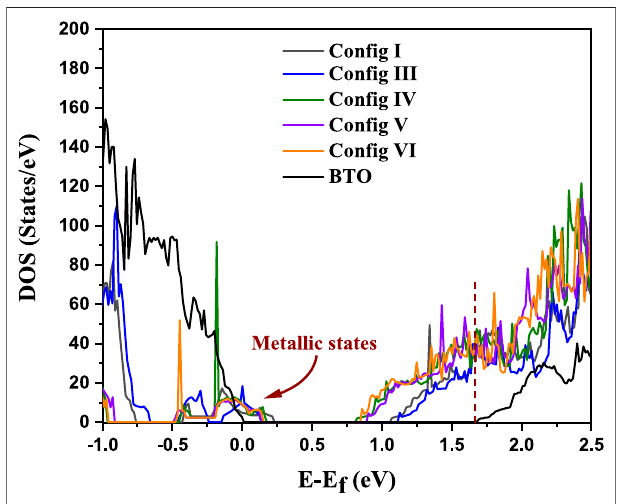
FIGURE2| DOScalculatedusingDFT(U (cid:2) 0)forallsixcon fi gurationsfor